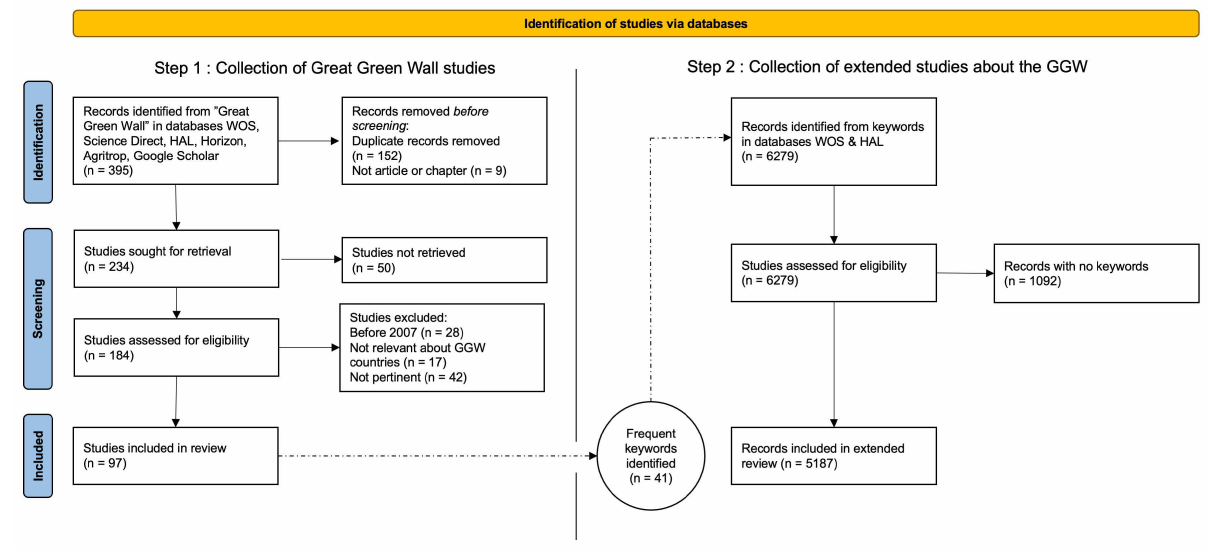
Figure 1. Review methodology based on PRISMA